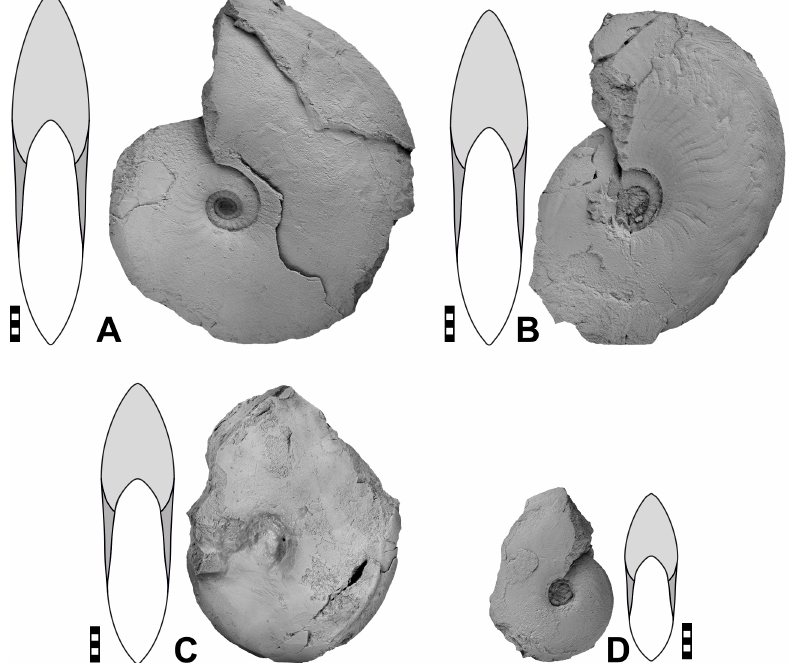
Fig. 13. Darkaoceras galeatum (Matern, 1931). A . Specimen MB.C.3658 (Ahlburg Coll.)